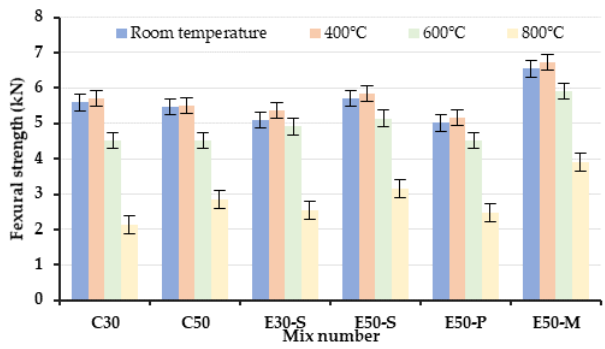
Figure 10. Results of flexural strength.